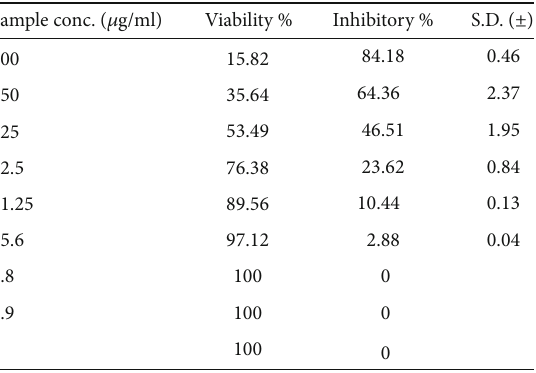
Figure 6: In vitro cell cytotoxicity (MB assay) on the CdSNPs biosynthesized by Aspergillus niger (RCMB 002002) against the MCF7, PC3, and A549 diseased cell